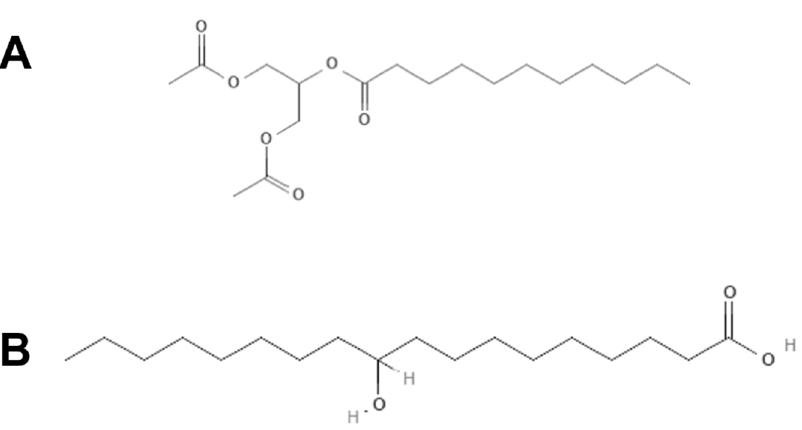
Figure 4. The structures of the surfactants of glyceryl laurate ( A ) and hydroxystearic acid ( B ). P. aeruginosa and B. cereus are among the bacterial species that show high susceptibil-